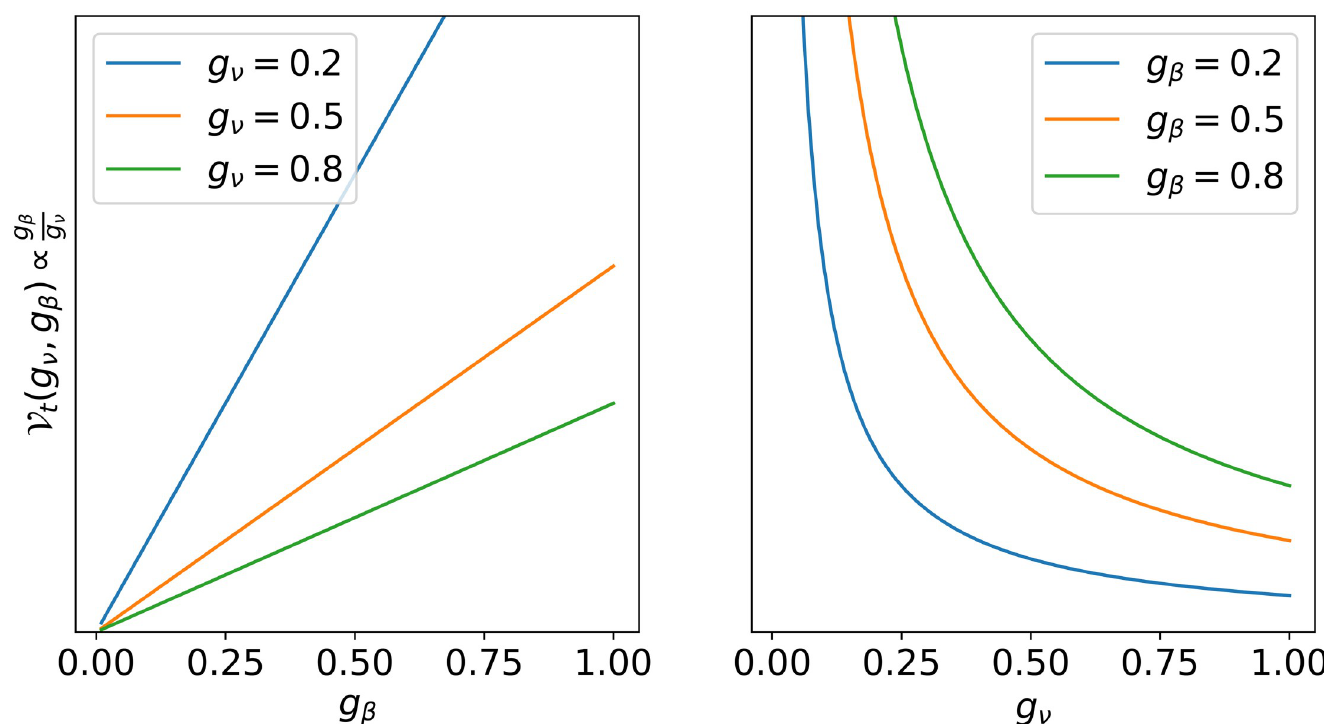
Fig 2. Trade-off based virulence function V right panel shows how V